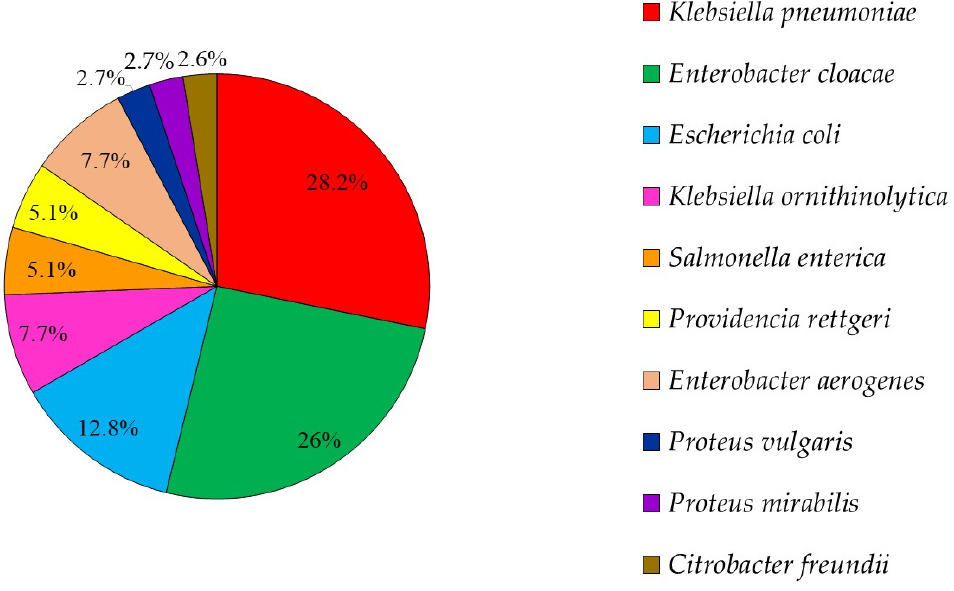
Figure 2. 3GCRE species distribution ( n = 39 pathogens).